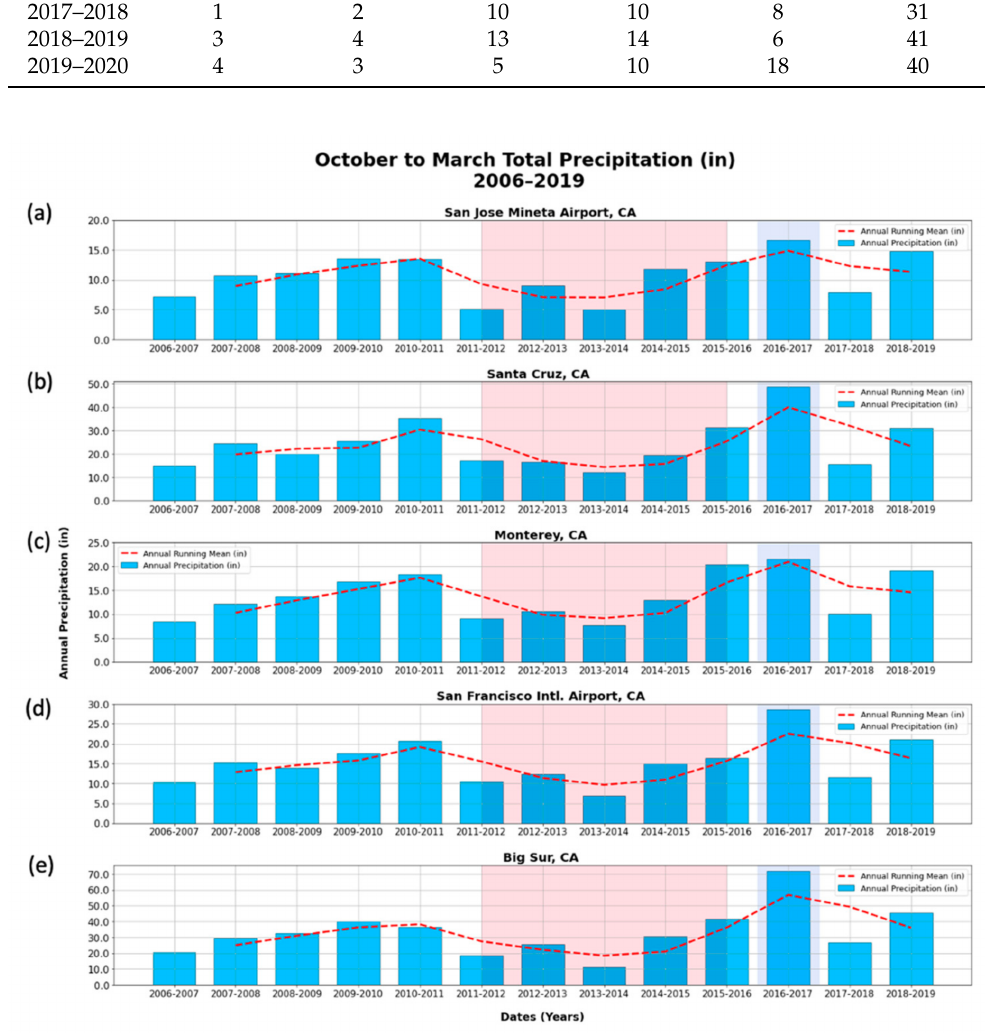
Figure 11. Annual precipitation for ( a ) San Jose Mineta Airport, ( b ) Santa Cruz, CA, USA, ( c ) Monterey, CA, USA, ( d ) San Francisco International Airport, and ( e ) Big Sur, CA, USA. Areas shaded in red highlight the third worst drought, while the extreme rain season is shaded in